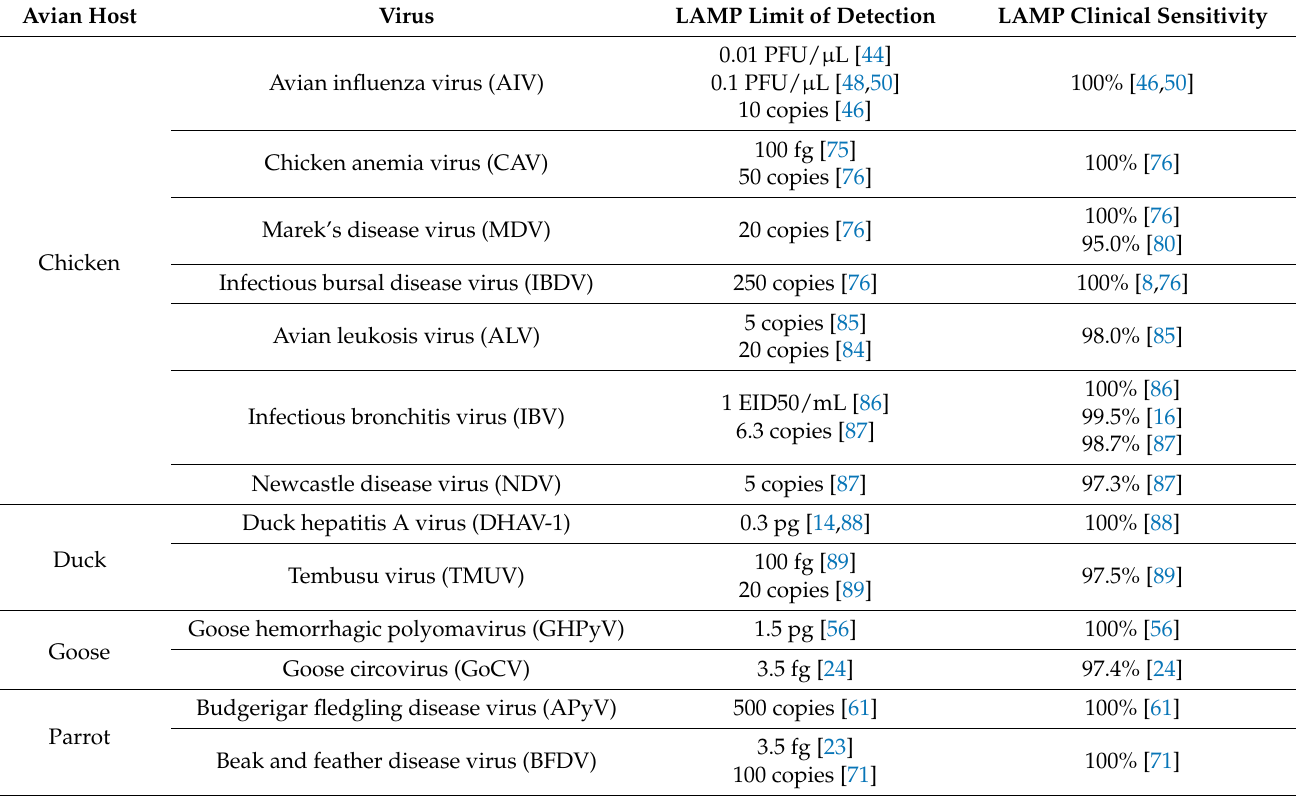
Table 1. LAMP applications in the detection of avian viruses from different avian hosts with optimal limit of detection and clinical sensitivity in diagnostic